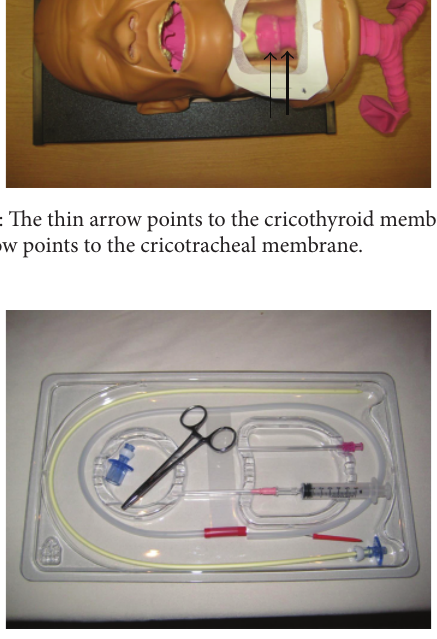
Figure 2: The Cook Retrograde Intubation Set (Cook Medical, Bloomington, IN, USA).